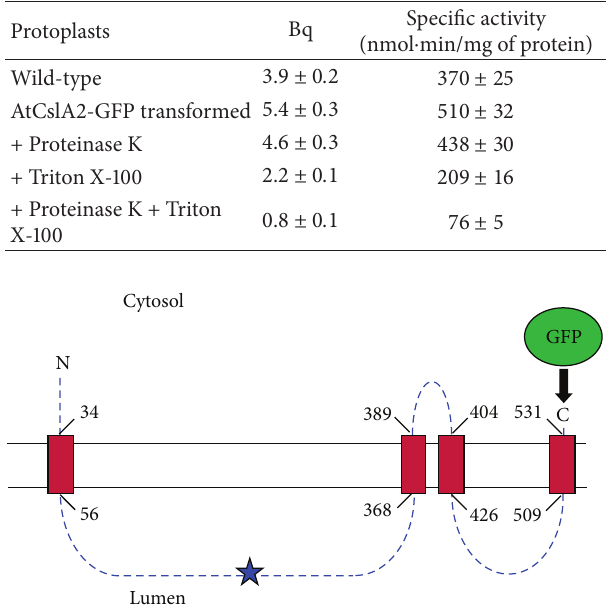
Figure 3: Hypothetical model of membrane topology of AtCslA2- GFP. Four transmembrane domains, predicted by TMHMM server, are reported in red, numbers mark location of the amino acids. Two hydrophilic region are predicted, the larger of which contains the predicted active site (blue star) and faces the Golgi